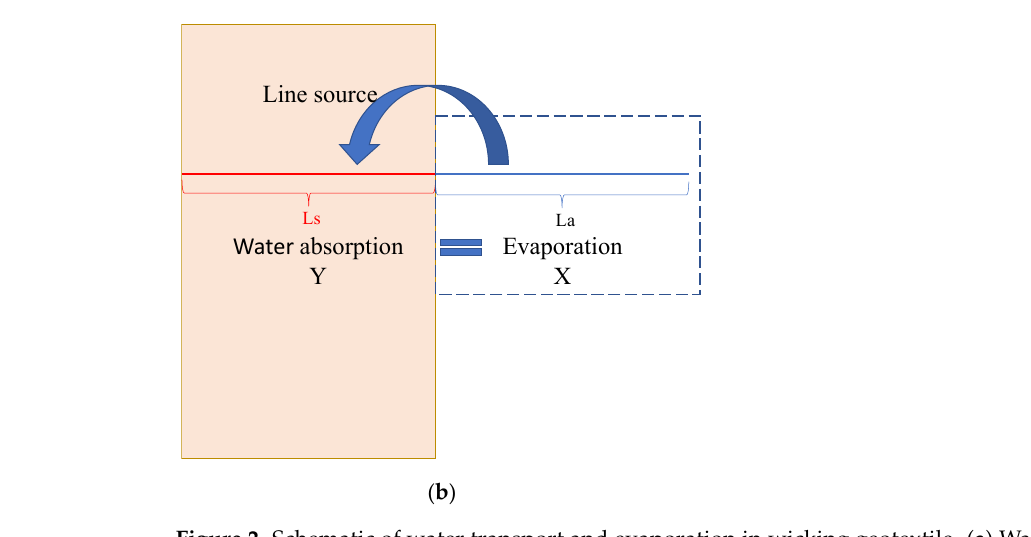
Figure 2. Schematic of water transport and evaporation in wicking geotextile. ( a ) Water transport and evaporation in wicking geotextile 5. ( b ) Simplified schematic of the evaporation model.